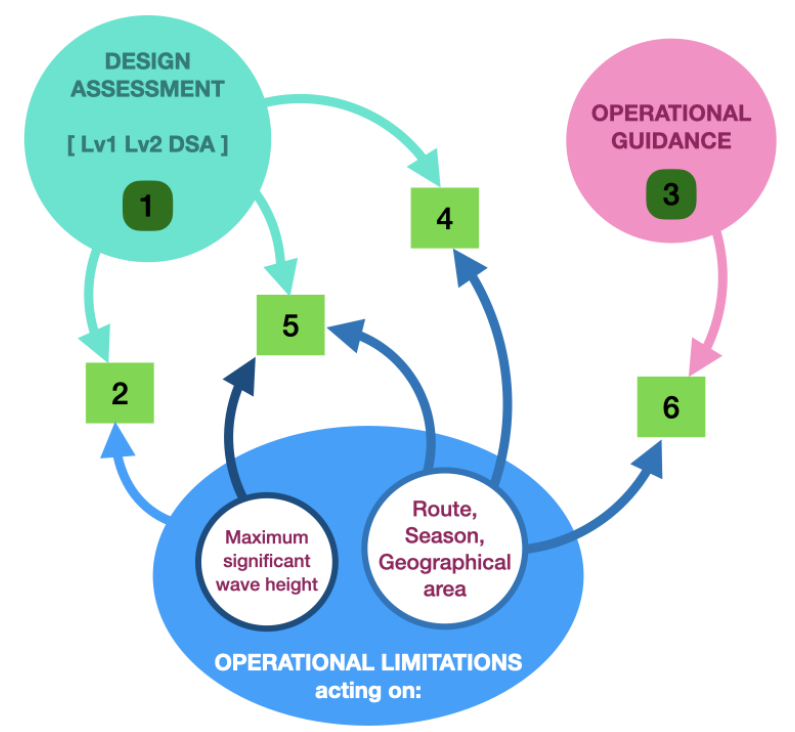
Figure 5. Graphical representation of all configuration of OM. (1) Unrestricted operation; (2) Limited operation; (3) operation using onboard OG; (4) operation in a specified area or in a specified route during a specified season; (5) limited operation in a specified area or in a specified route during a specified season; (6) operation using onboard OG in a specified area or in a specified route during a specified